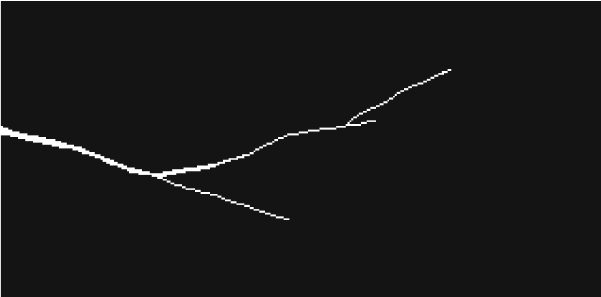
Figure 9: Imaginary homogenous porous media model with real microfracture: the black color is the homogenous porous media, while the white color is the microfractures.